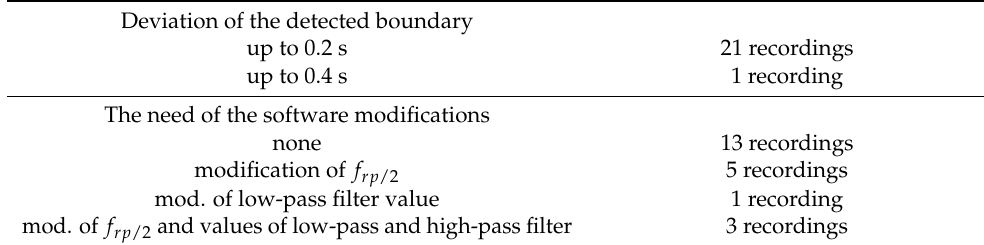
Table 2. Success of detection of boundaries of respiratory phases–very good recordings/recordings with minimal undesirable